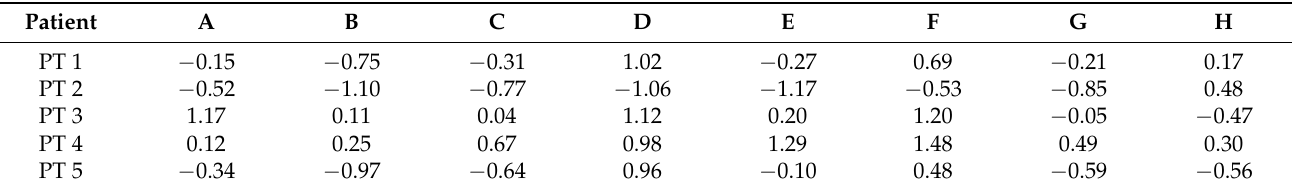
Table 4. Difference (mm) measured on five patients between planning and postoperative. PT,